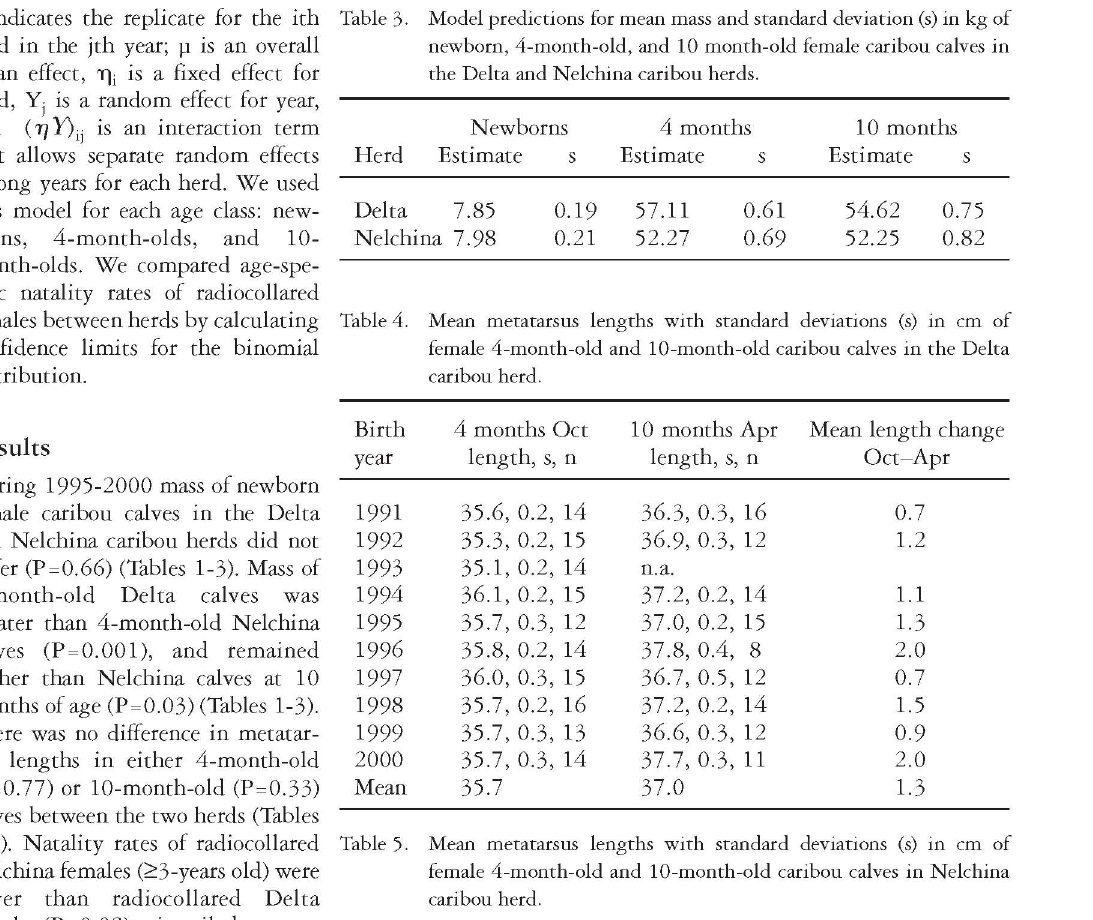
Table 4. Mean metatarsus lengths with standard deviations (s) in cm of female 4-month-old and 10-month-old caribou calves in the Delta caribou herd.